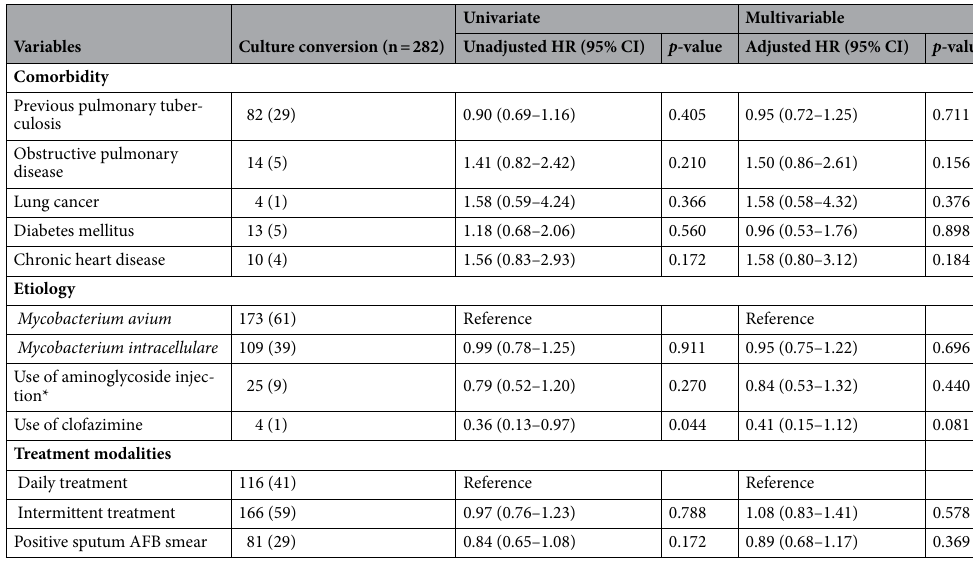
Table 4. Factors associated with culture conversion in the BACES mild group (n = 331). Data are presented as n (%) or median (interquartile range). BACES body mass index, age, cavity, erythrocyte sedimentation rate, and sex, HR hazard ratio, CI confidence interval, AFB acid-fast bacilli. *Patients who received aminoglycoside injection for > 3